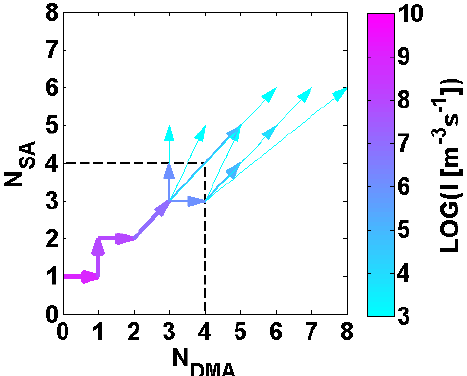
Fig. 5. The major movement of clusters out of the system. The system boundaries are depicted by dashed black lines. The line colour gives the total flux between clusters, and the arrow indicates the direction of the flux. Line thickness is used as an additional guide for the eye (thicker lines mean higher flux). The colour scale is the base-10 logarithm of the flux (given in m − 3 s − 1 ).